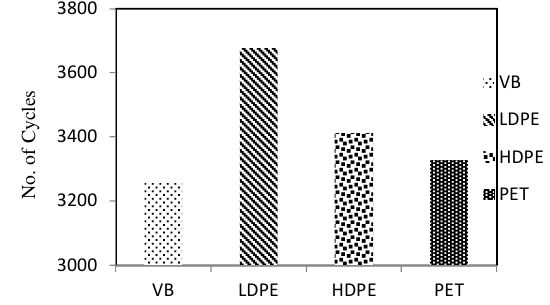
Fig. 10: Fatigue performance of asphalt